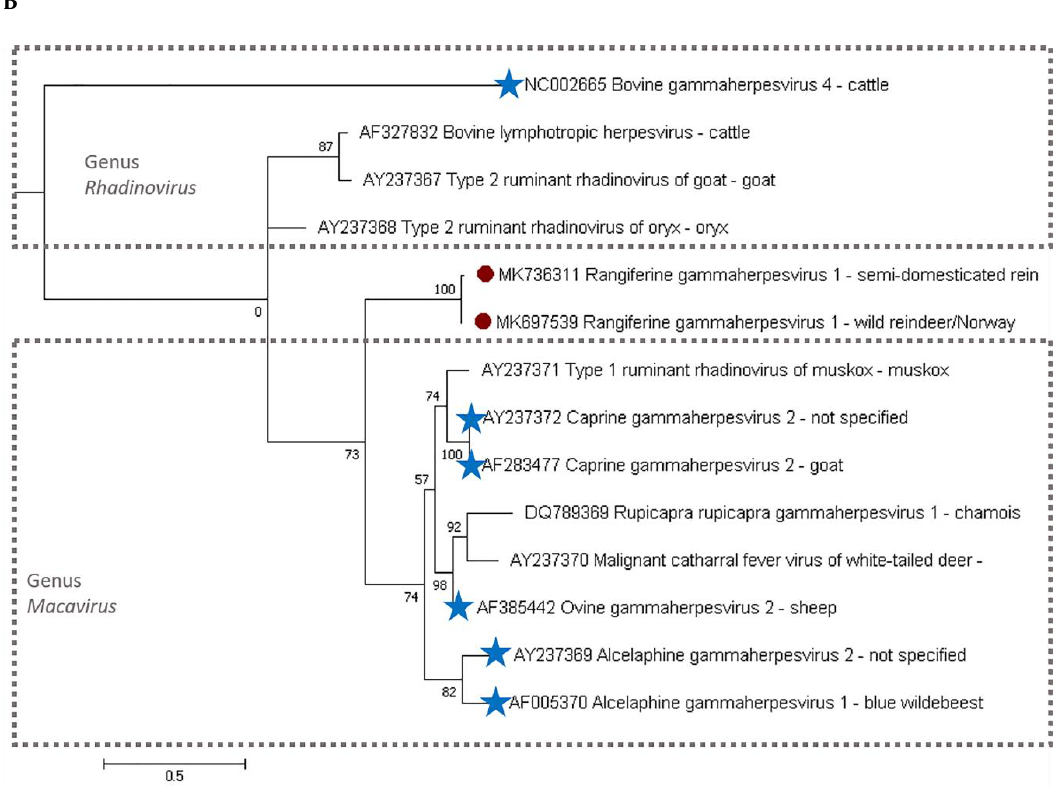
Figure 3. MrBayes Bayesian inference phylogenetic tree of a ClustalW alignment of gammaherpesvirus DNA polymerase nucleotide sequences ( A ) and gammaherpesvirus DNA glycoprotein B sequences ( B ). • represents the reindeer sequences obtained in this paper. Dotted grey boxes represent the two gammaherpesvirus genera depicted in this analysis. One should note that the genus Macavirus has been established as a new denomination for a previous type 1 rhadinovirus (malignant catarrhal fever (MCF)-like) group. This explains the presence of some rhadinovirus names in sequences now included in the Macavirus genus. represents sequences of viral species officially classified in its respective genus by the International Commission for Taxonomy of Viruses (ICTV), whereas all other sequences are classified tentatively (from GenBank taxonomy lists). The scale bar indicates the number of nucleotide substitutions per site.